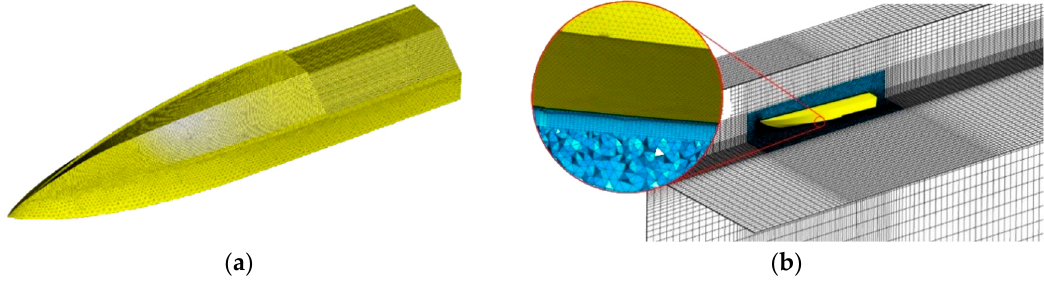
Figure 4. Mesh generation and refinement: ( a ) Bottom plan; ( b ) Domain and boundary layers.